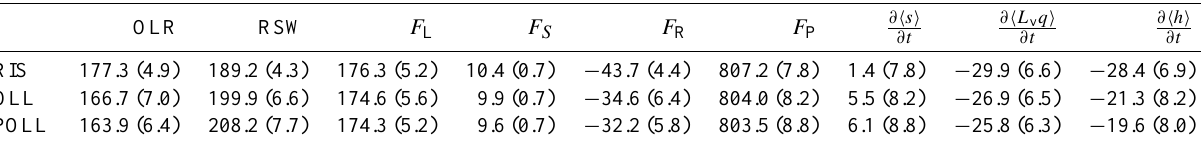
Table 2. Ensemble means of OLR, RSW, and terms in the vertically-integrated s , q , and h budgets for PRIS, POLL, and SPOLL. Ensemble standard deviations are shown in parentheses. Presented quantities are averaged from 12:00UTC 19 January to 12:00UTC 25 January. Units areWm − 2 .